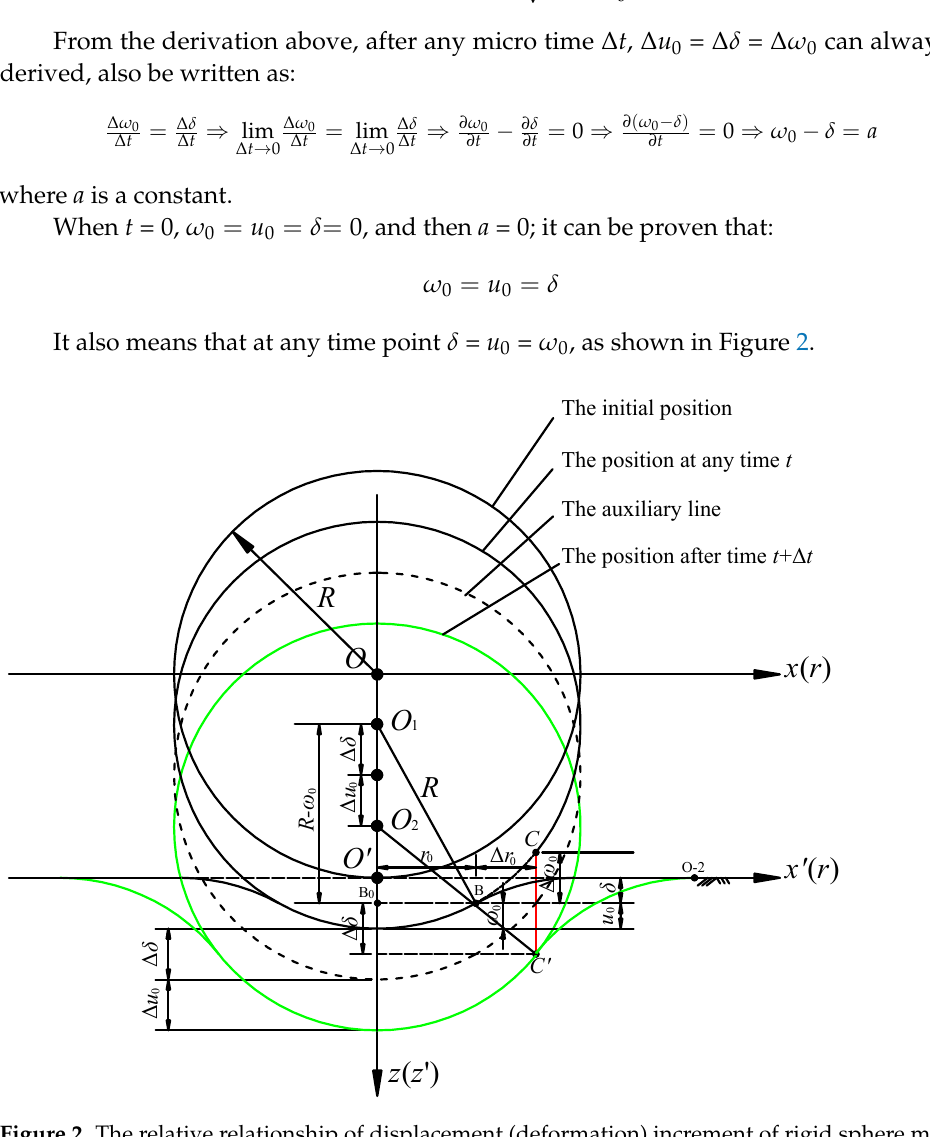
Figure 2. The relative relationship of displacement (deformation) increment of rigid sphere motion state in contact boundary.